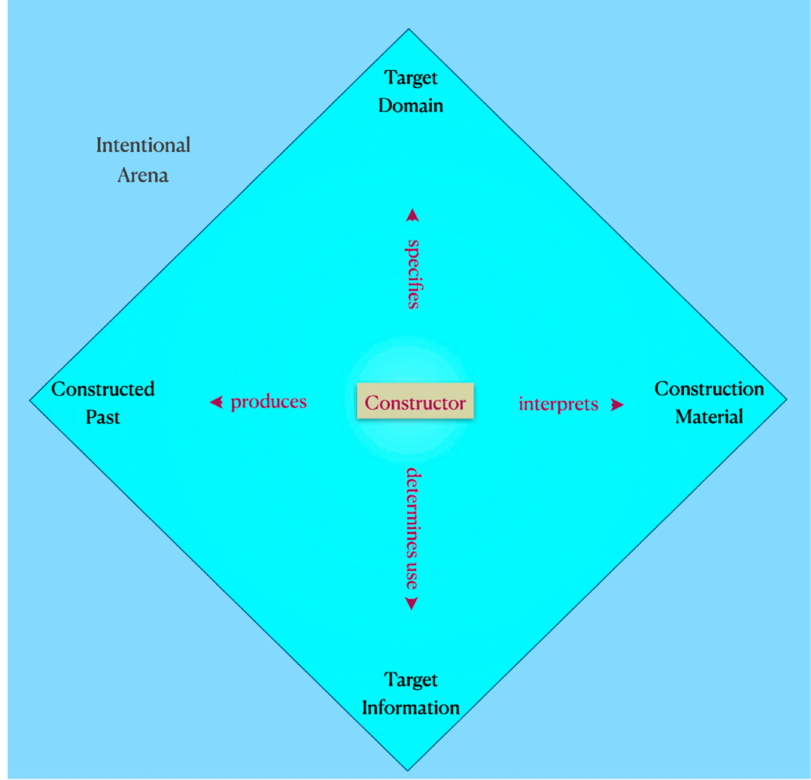
Figure 4. Constructor Activities. Activities of the Constructor superimposed on the background of Figure 3. The activities are not independent of one another. For example, specification of the Target Domain substantially impacts the interpretation of Construction Material, the use of Target Information, and the production of the Constructed